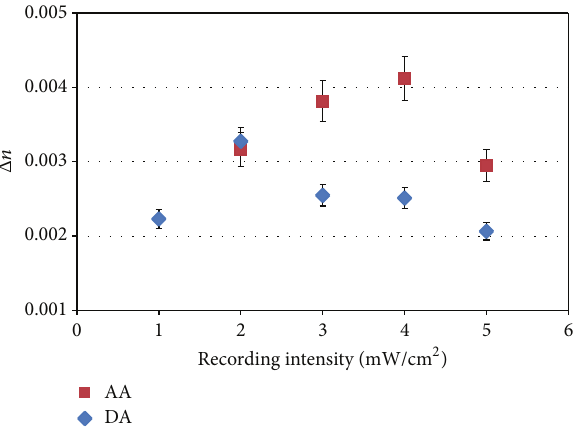
Figure 6: Δ𝑛 versus recording intensity for the DA and AA pho- topolymers at a spatial frequency of 1000 L/mm in 60 ± 10 𝜇 m thick layers. The total exposure energy was kept constant at 100mJ/cm 2 . Data is expressed as an average of five Δ𝑛 measurements ± standard deviation for each Δ𝑛